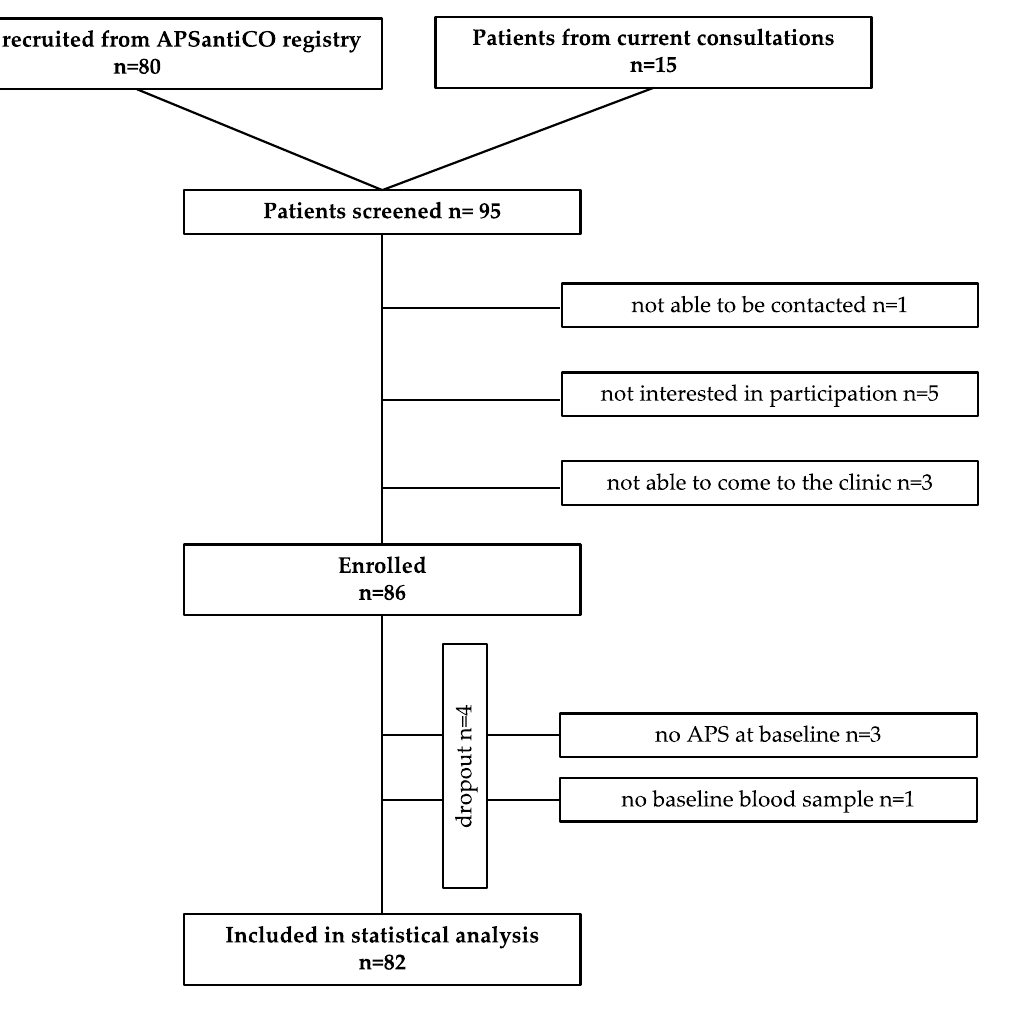
Figure 2. Flowchart of patient inclusion.